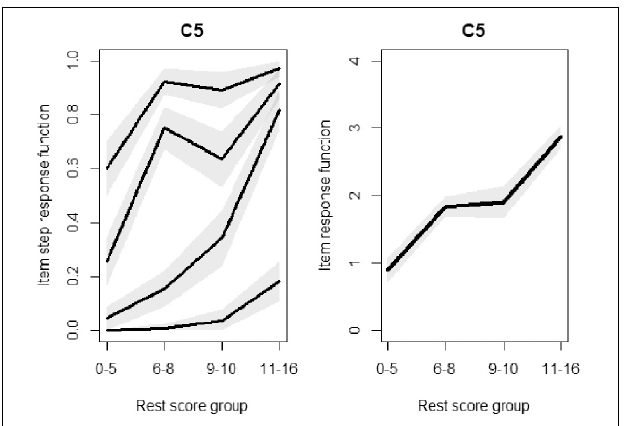
FIGURE 3 | Violation of monotonicity evaluation for C5, as an example.